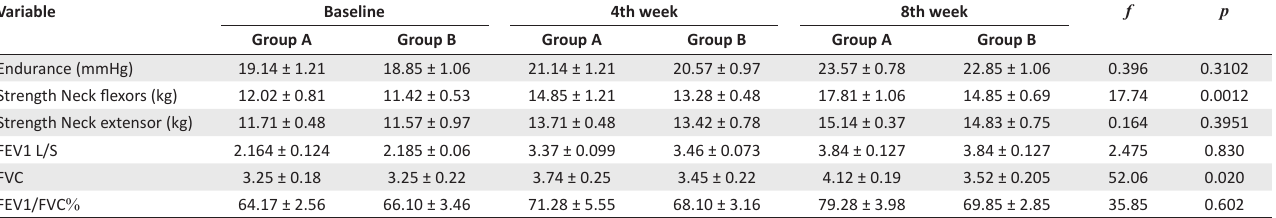
TABLE 2: Intergroup comparison of variables before and after the intervention at beseline, 4th and 8th week.